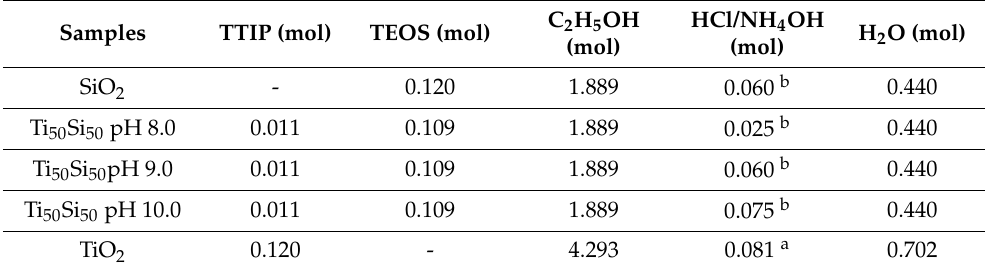
Table 1. Moles of components in the preparation of Ti 50 Si 50 oxide synthesized at various pH values.